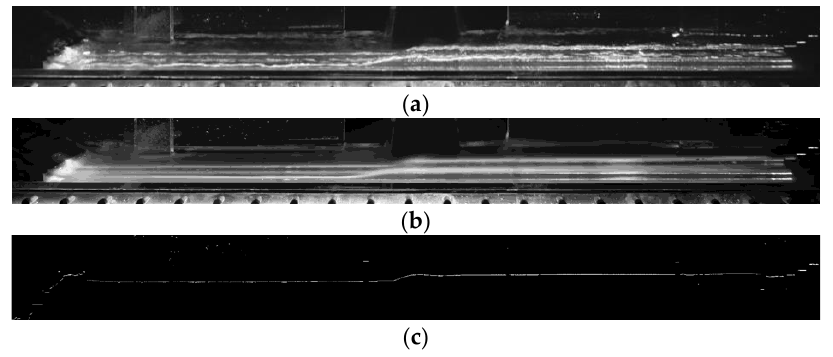
Figure 7. Inundation depth measurements using the laser image (Sec. A): ( a ) Instantaneous image; ( b ) Time-averaged image; ( c ) Extracted water surface elevation.